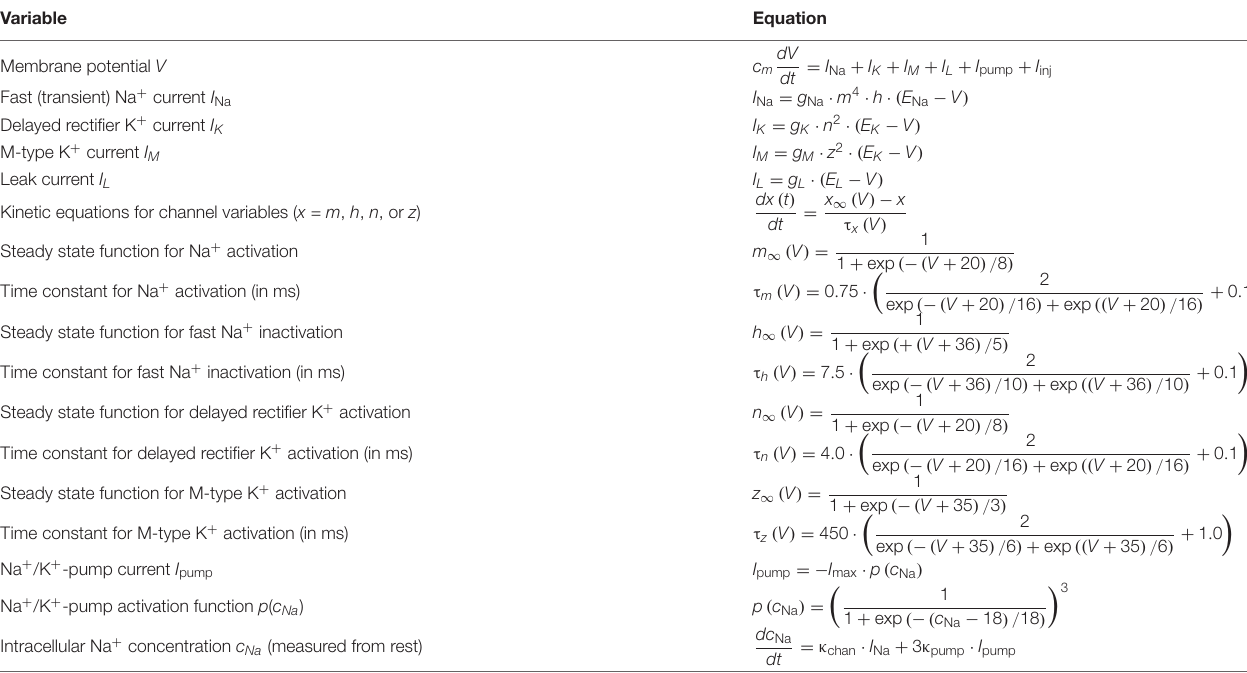
TABLE 1 | T cell model equations. Variable Equation